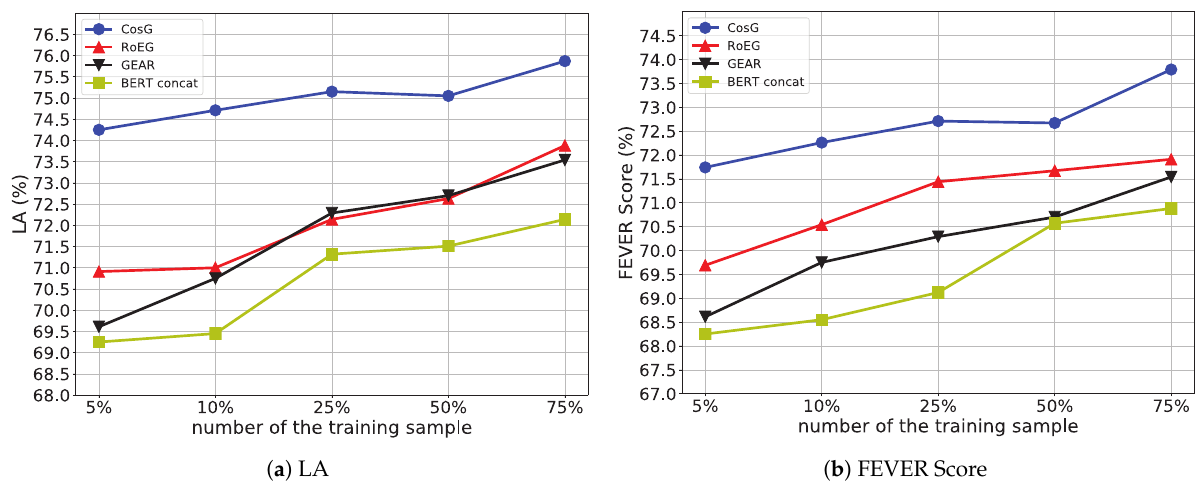
Figure 5. Performance on the development set where models are trained by different number of samples